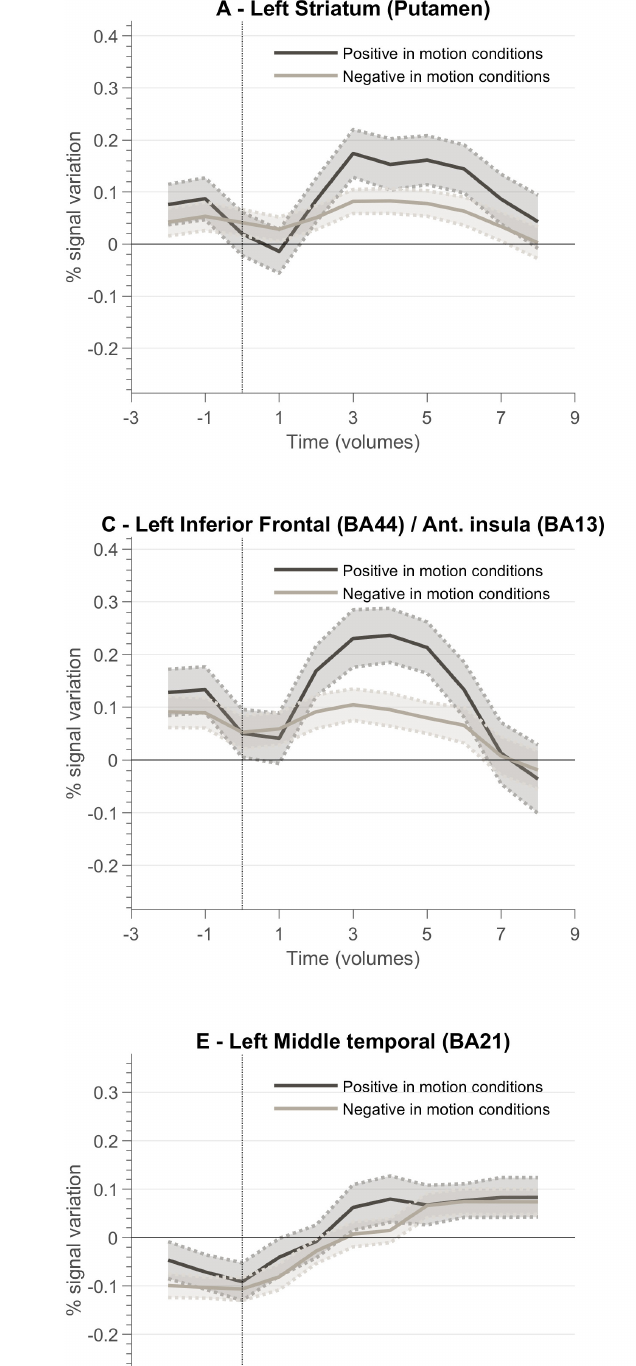
Frontiers in Human Neuroscience |